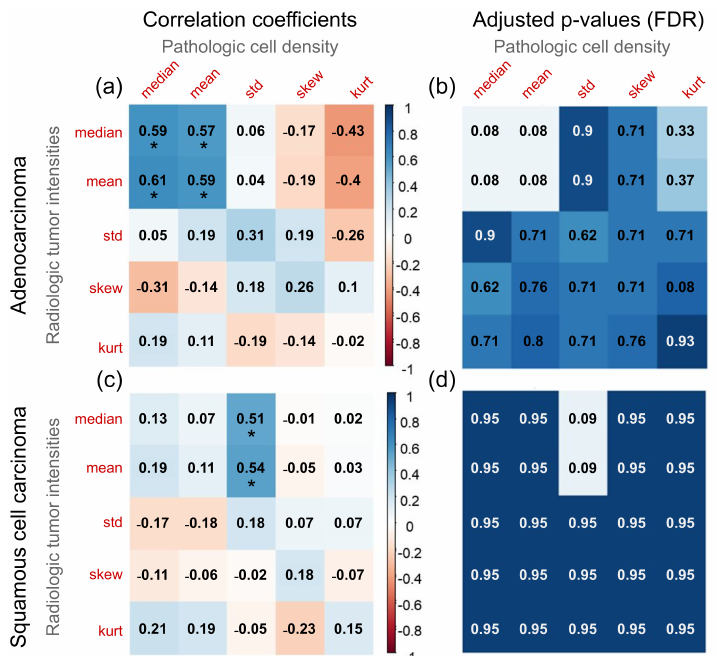
Figure 7. Heatmap visualizations for ( a , c ) Spearman’s rank correlation coefficients between pathologic cell density and radiologic intensity statistics (red = negative correlation, blue = positive correlation). ( b , d ) similarly visualized adjusted p -values for each pair of features as a heatmap, after False Discovery Rate (FDR) correction for multiple hypotheses testing.